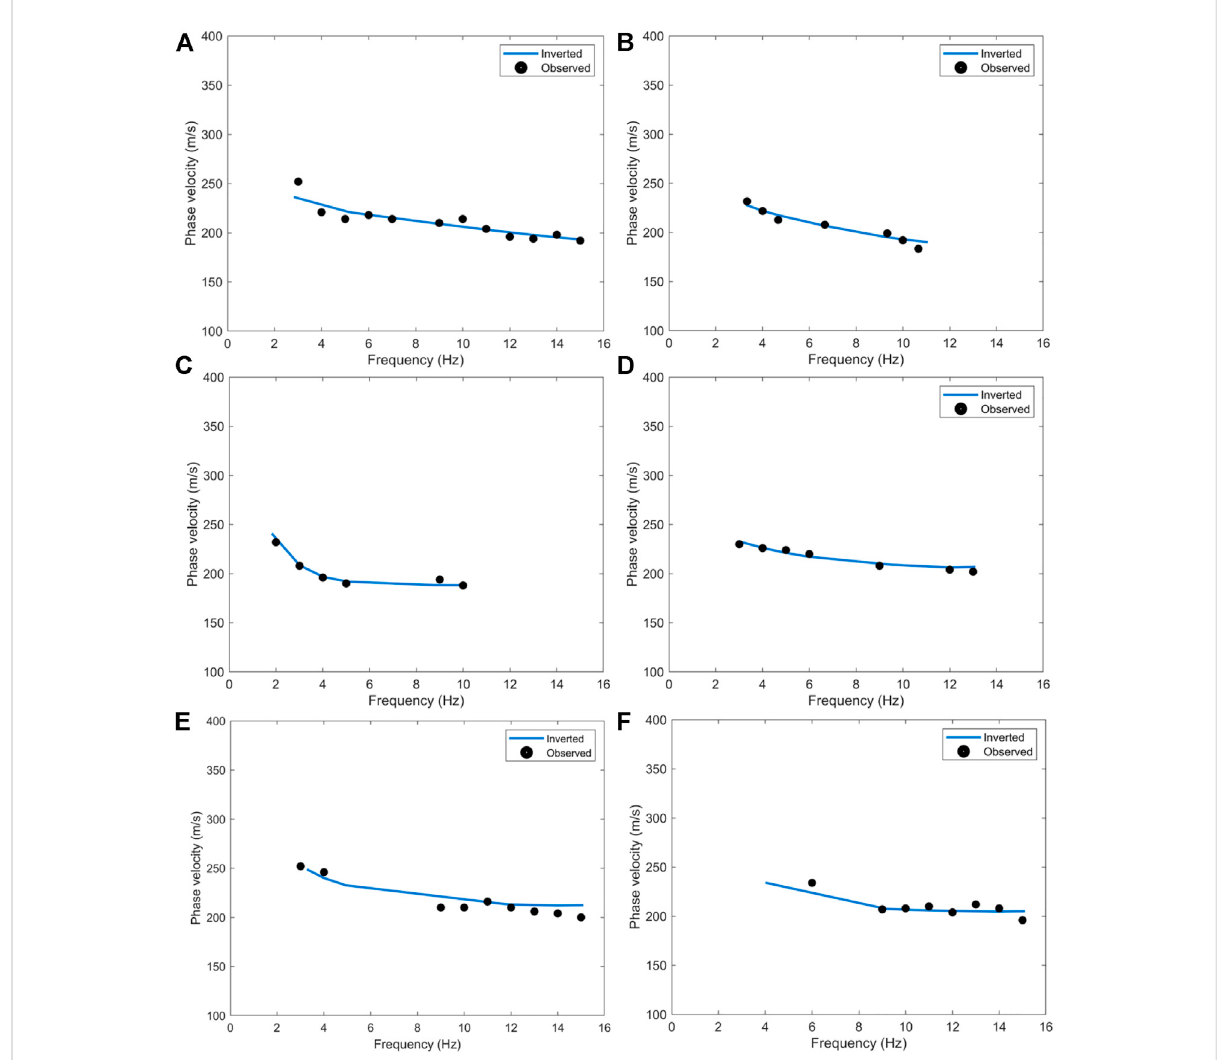
FIGURE 10 (A – F) The fi t of the forward fundamental-mode dispersion curve using the inverted velocity in Figures 9A – F to the picked one in Figures 8A – F.